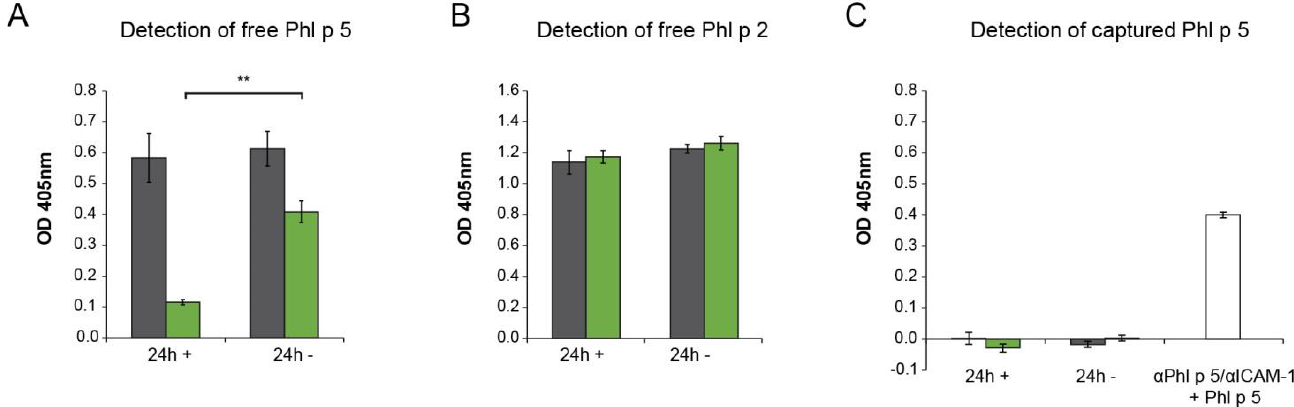
Figure 4. Epithelial-cell-bound α Phl p 5/ α ICAM-1 conjugates significantly reduce penetration of Phl p 5 but not of Phl p 2, an unrelated grass pollen allergen. Detection of free ( A ) Phl p 5 and ( B ) Phl p 2 or conjugate-captured ( C ) Phl p 5 in apical (gray bars) and basolateral media (green bars) of 16HBE14o- cell monolayers that had been loaded with ( + ) or without ( − ) α Phl p 5/ α ICAM-1 conjugates. OD values corresponding to concentrations of free ( A ) Phl p 5 and ( B ) Phl p 2, or bound ( C ) Phl p 5 measured 24 h after +/ − application of conjugates onto 16HBE14o- cells are shown as means of triplicates ± SDs. Depicted values are background-subtracted. The value ** p < 0.01 shows significant difference. To verify the assay functionality performed for conjugate-bound Phl p 5 ( C ), preformed complexes of α Phl p 5/ α ICAM-1 and Phl p 5 were applied. Representative bars of five independent experiments ( A , C ) are shown.